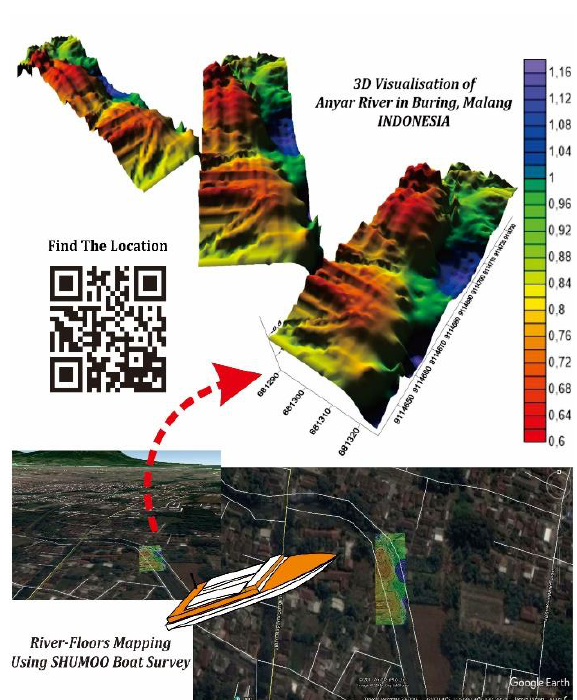
Figure 15. Corrected bathymetry points elevation.